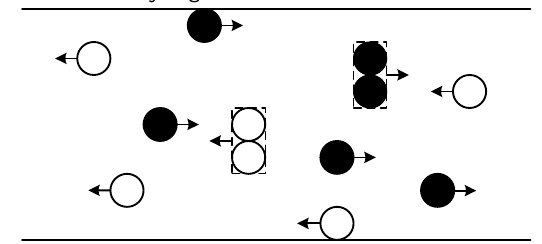
Fig. 1. Schematic illustration of the pedestrian counter-flow considering paired behavior in a channel. The black circle represents the right walker, and the white circle represents the left walker. The two in a dashed rectangle in black and in white represent the paired right walkers and the paired left walkers respectively.